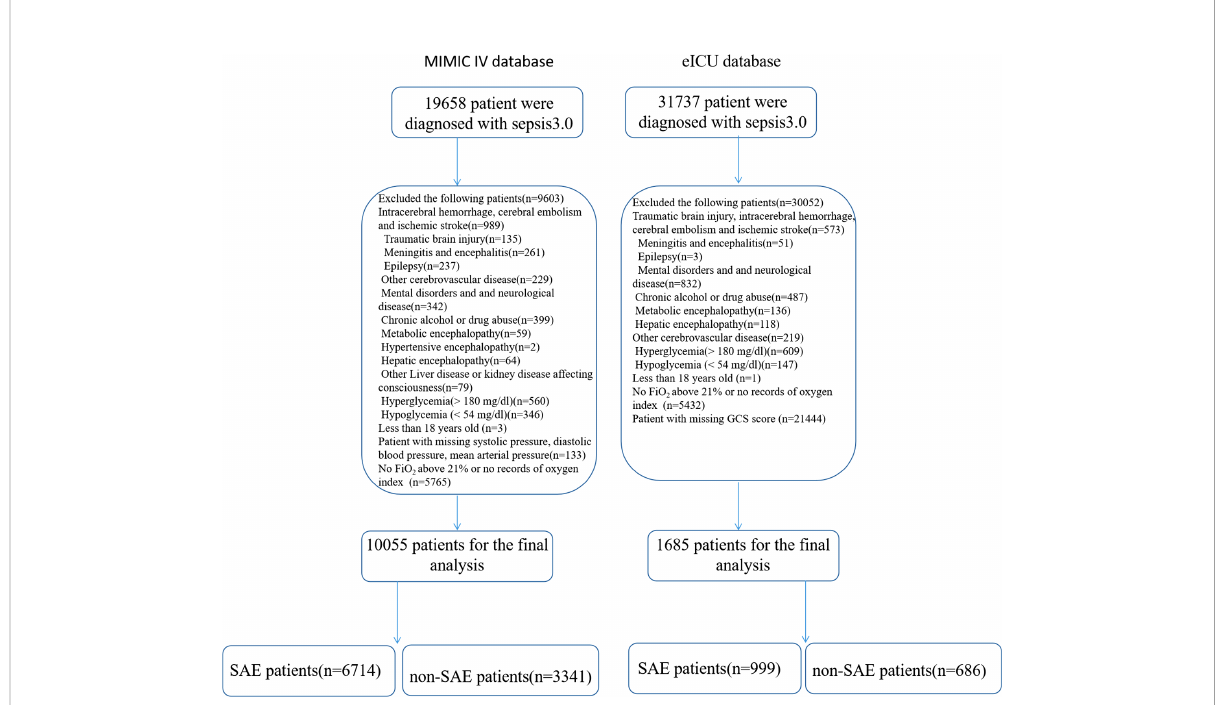
FIGURE 1 Flow chart for patient selection. ICU, intensive care unit; PaCO 2 , partial pressure of carbon dioxide; FiO 2 , the fraction of inspired